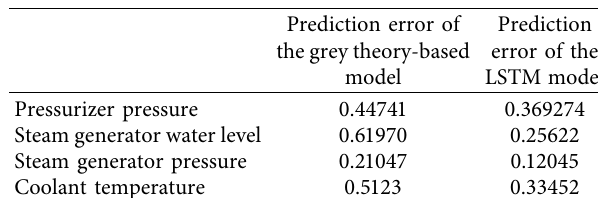
Table 5: The prediction error of the model based on the grey